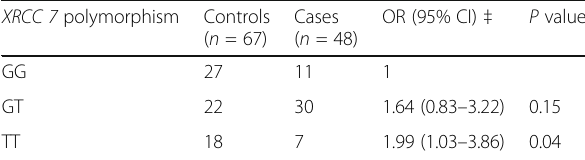
Table 3 The ALL cancer risk by positive parents ’ smoking habit and the XRCC7